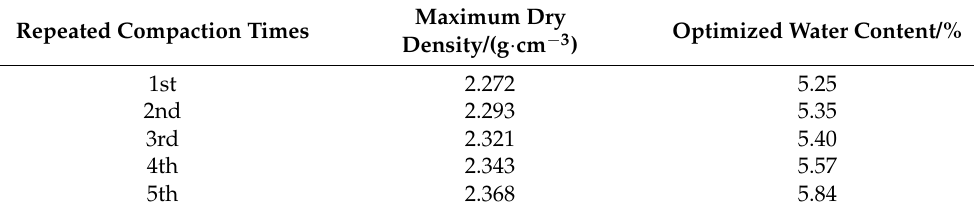
Table 4. Test results of repeated